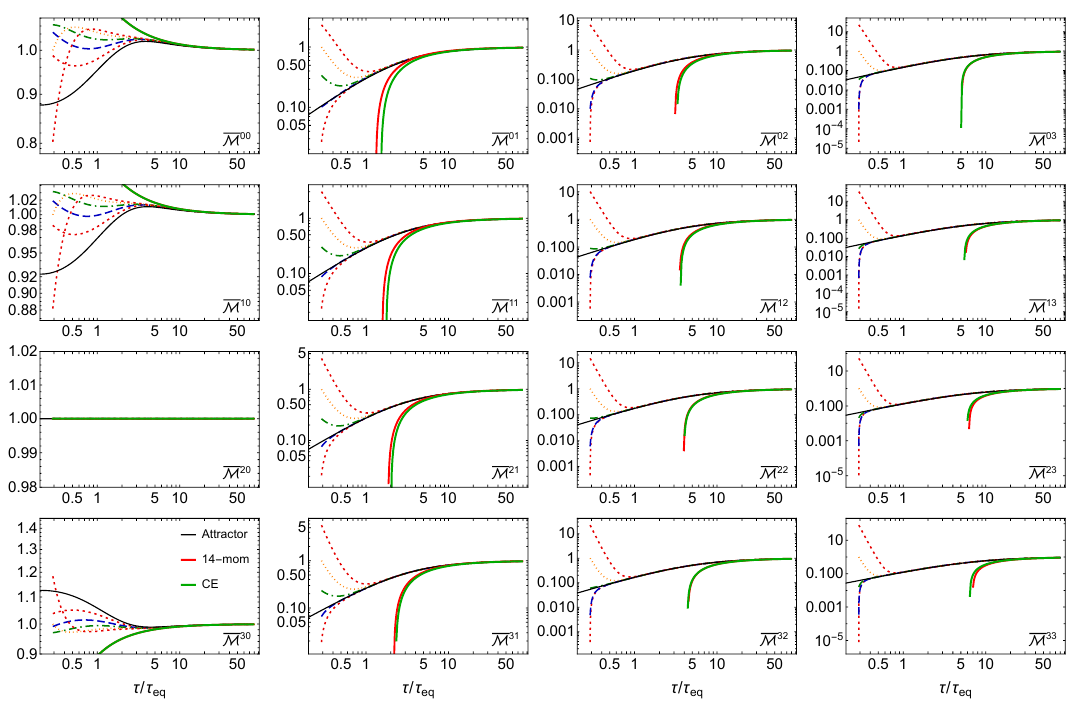
Figure 6 . Scaled moments M nl as a function of rescaled time for the case m = 5 GeV. Initial conditions and line styles are the same as in figure